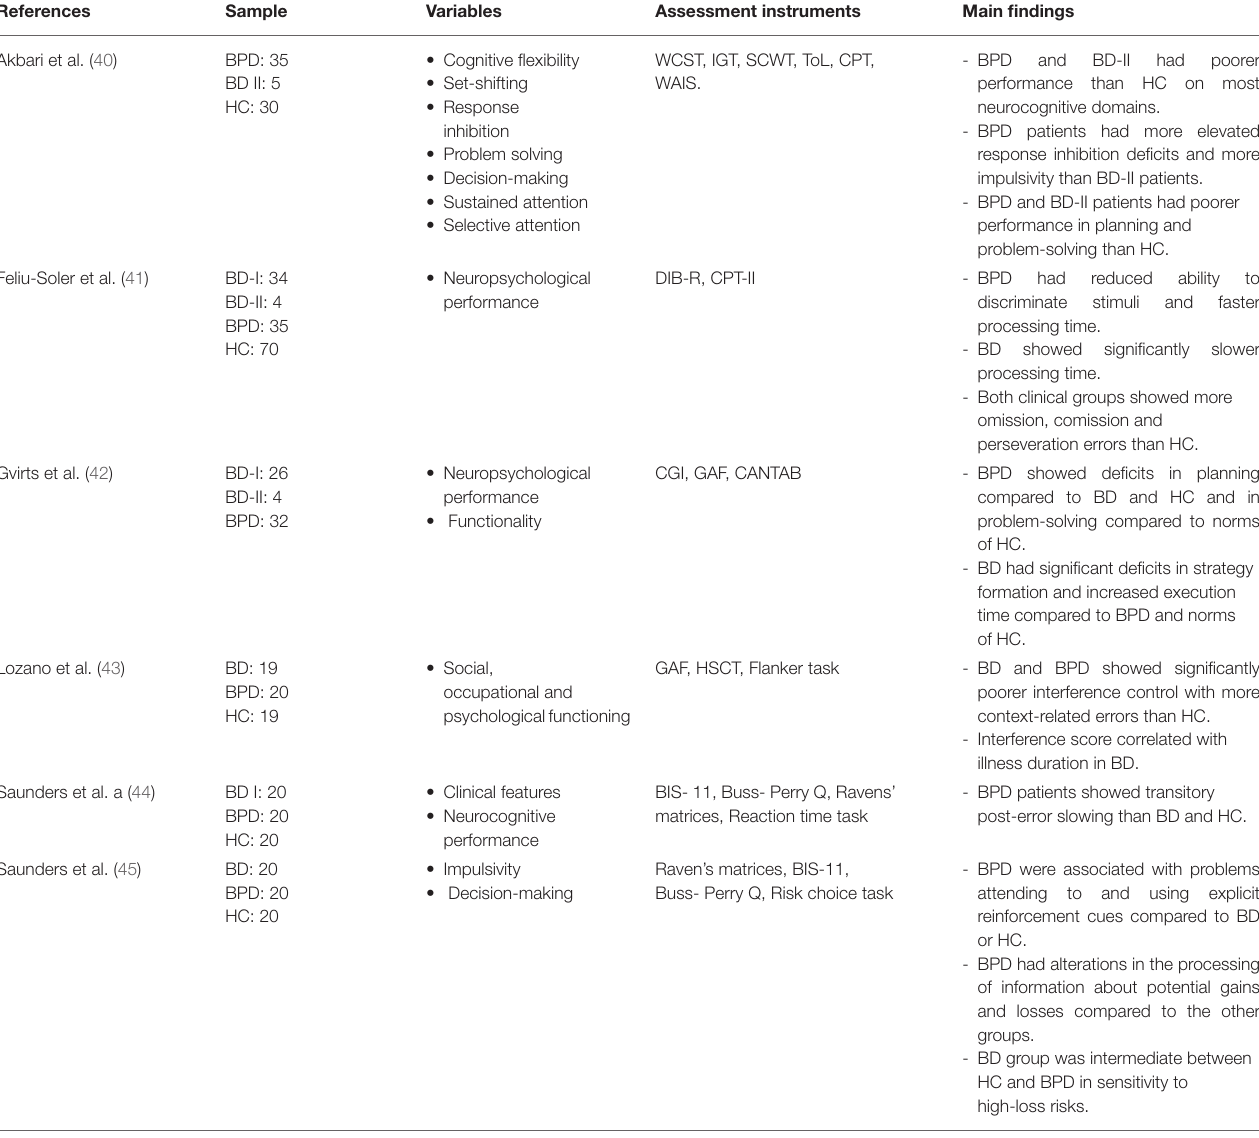
TABLE 2 | Neuropsychological differences between bipolar disorder and borderline personality